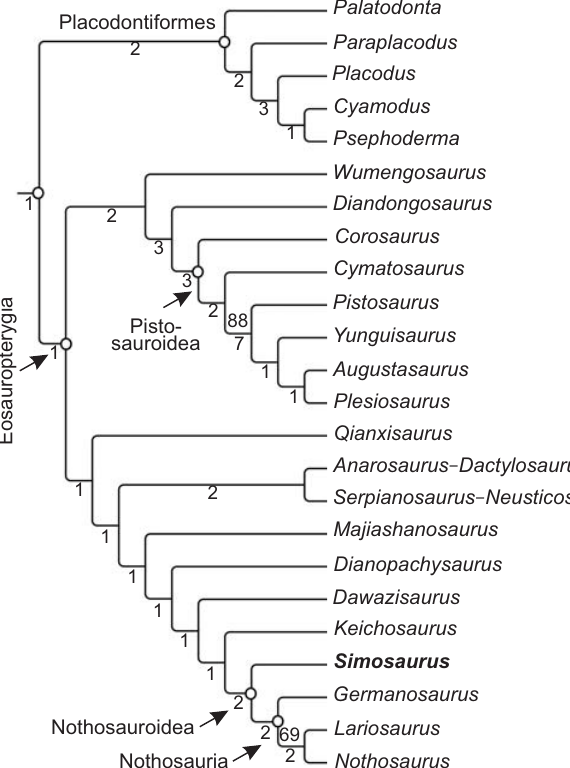
Fig. 7. Phylogeny of Sauropterygia from the strict consensus tree obtained from our phylogenetic analysis based on the modified data matrix of Cheng et al. (2016). The phylogenetic analysis resulted in four most parsimonious trees, with a length of 615 steps (CI = 0.311; RI = 0.663; RC = 0.206). Bootstrap frequencies that exceed 50 per cent (top) and Bremer support values (bottom) are